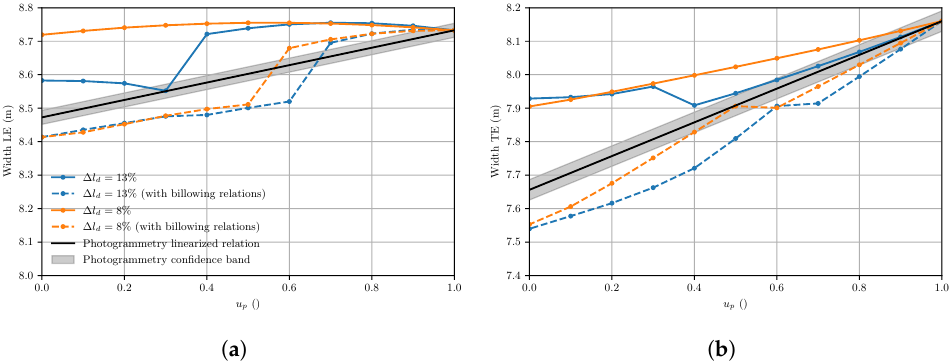
Figure 10. Evolution of the LE widths ( a ) and TE widths ( b ) as a function of the power setting u p . The photogrammetry provided only the extreme values of the tip distances—i.e., the linear dependency being in between u p = 1 and 0 is a pure assumption. In fact, the simulations showed more complex behavior with an abrupt change that corresponds to the state in which the steering tape and the bridle line connecting it to the TE tip are parallel. This is illustrated in Figure 11.